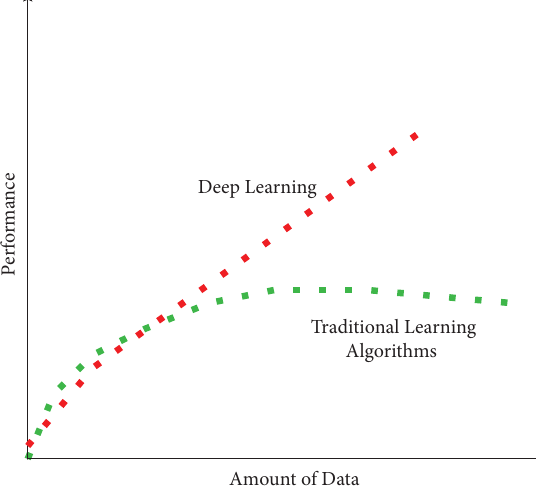
Figure 2: Data vs. performance comparison source